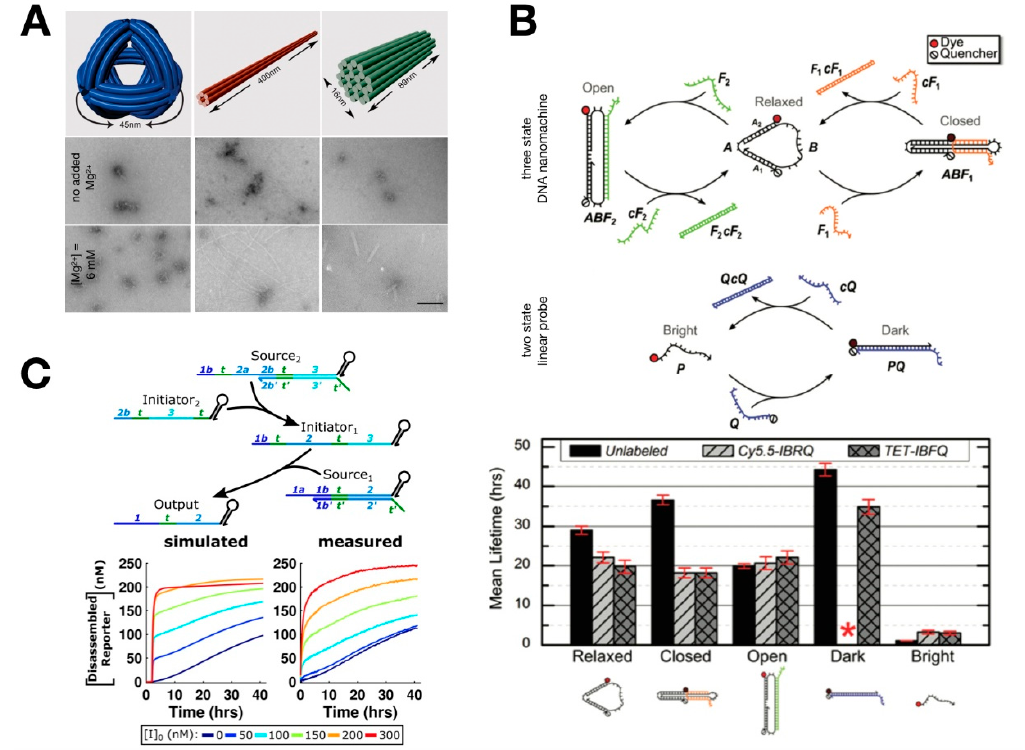
Figure 10. Characterization of DNA structures and circuits in serum. ( A ) 3D model of DNA nanooctahedron (DNO), six-helix bundle nanotube (NT), and 24-helix nanorod (NR) (top). TEM images of nanostructures incubated in unmodified (middle) or Mg 2 + -adjusted (bottom) medium. Structural integrity is maintained for all three designs with additional Mg ion. Scale bar = 100 nm. Reproduced with permission from [129]. ( B ) (top) Three-state DNA nanomachine transitions between relaxed, closed, and open states with the addition of fuel strands and their complements. The two-state linear probe transitions between bright and dark states upon hybridization of the dye-labeled probe strand, P, and the quencher-labeled strand, Q. (bottom) Mean lifetimes of the DNA nanomachines and linear probes show considerable di ff erences in degradation rates. Reproduced with permission from [130]. ( C ) (top) Schematic of two-layer DNA cascade reaction. (bottom) Simulation results of a two-layer cascade with 5 bp toeholds using the fitted parameters and experimental measurements. Reproduced with permission from [133].